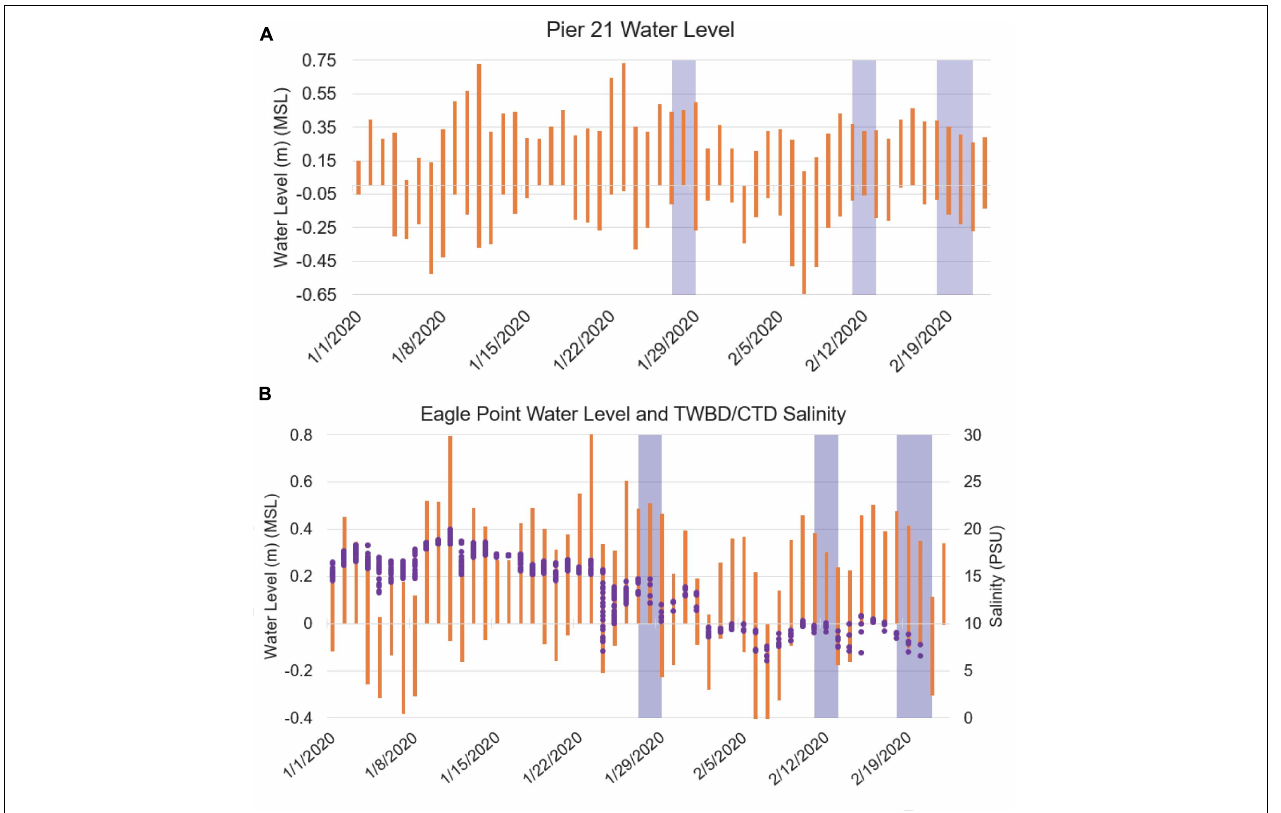
FIGURE 4 | Water levels from NOAA Pier 21 (A) and Eagle Point Stations (B) for the months of January and February 2020, as well as the salinity (PSU) obtained from Texas Water Development Board (TWBD-TRIN) station (1/1/2020-2/5/2020) and from the TAMUG-TRIN CTD station (2/6/2020-2/20/2020). Shading represents our precipitation sampling